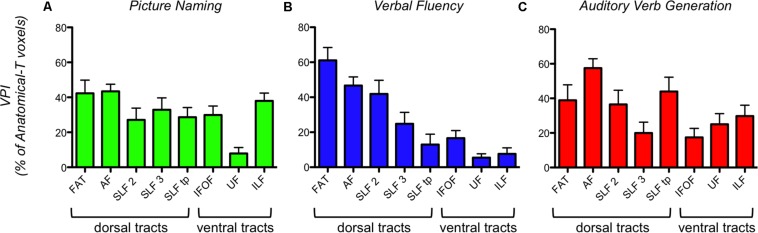
Task-specific VPI (Voxel Percentage Index) of each fMRI-T fiber tract in 16 healthy controls. (A) PN; (B) VF; (C) AVG. The bar graph represents the mean and the standard error.